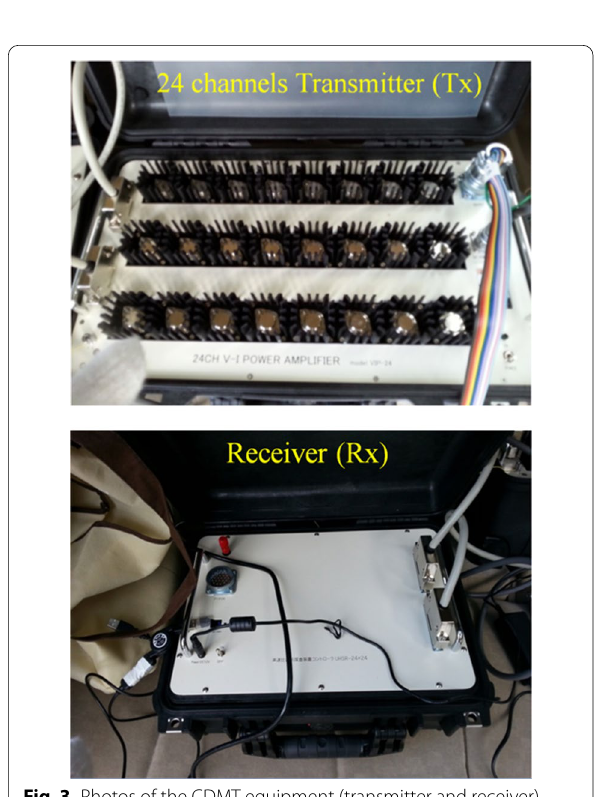
Fig. 3 Photos of the CDMT equipment (transmitter and